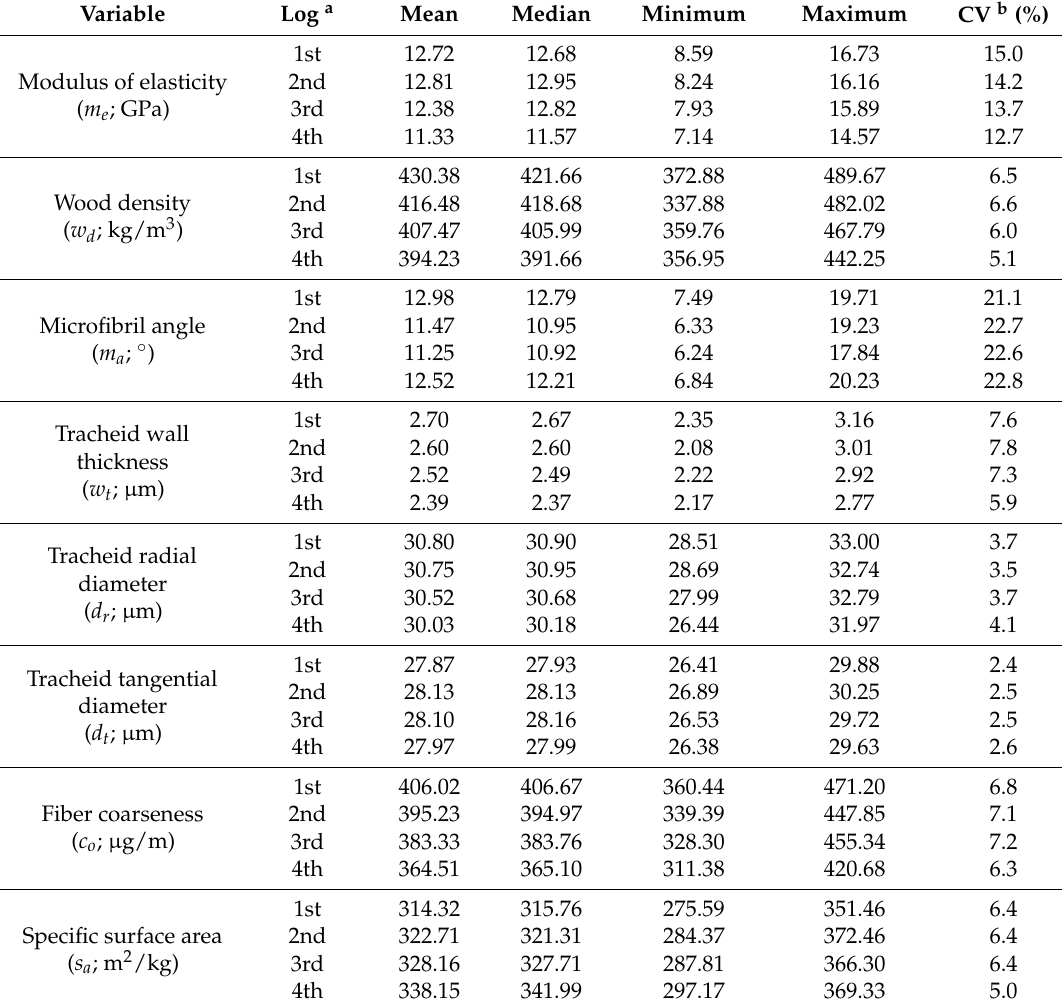
Table 5. Descriptive statistical summary of the fiber attributes of by log position ( n = 243 of which 61, 61, 61 and 60 were first, second, third and fourth positioned logs,